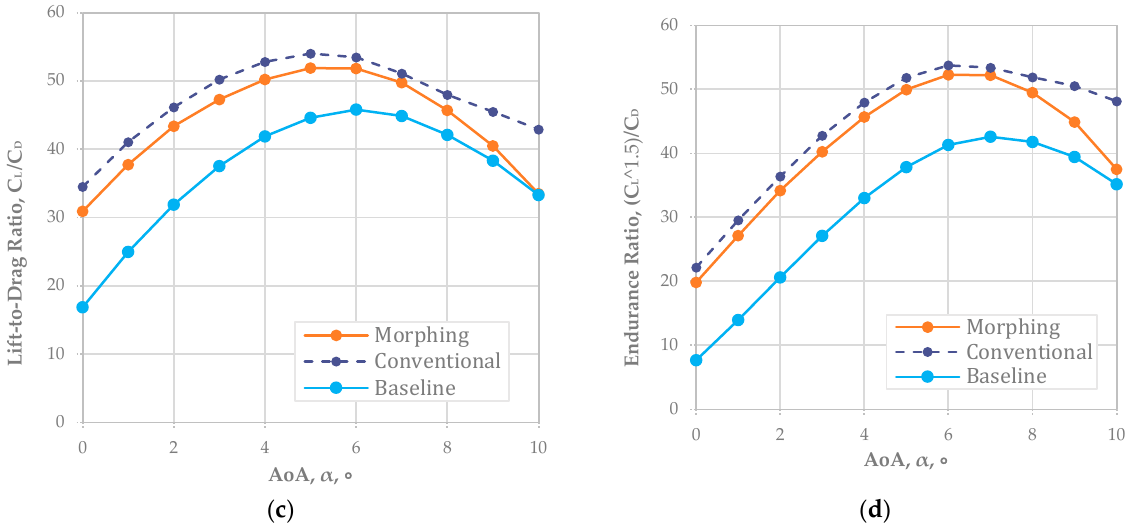
Figure 3. Matching L morphing (NACA 4410) and conventional airfoil plots (Re = 778,179): ( a ) L plot; ( b ) D plot; ( c ) L/D ; ( d ) endurance ratio Figure 3c,d are directly related to 𝐶 (cid:3013) , 𝐶 (cid:3005) , and 𝐶 (cid:3013) 𝐶 (cid:3005) ⁄ . The 𝐶 (cid:3013) 𝐶 (cid:3005) ⁄ indicated the